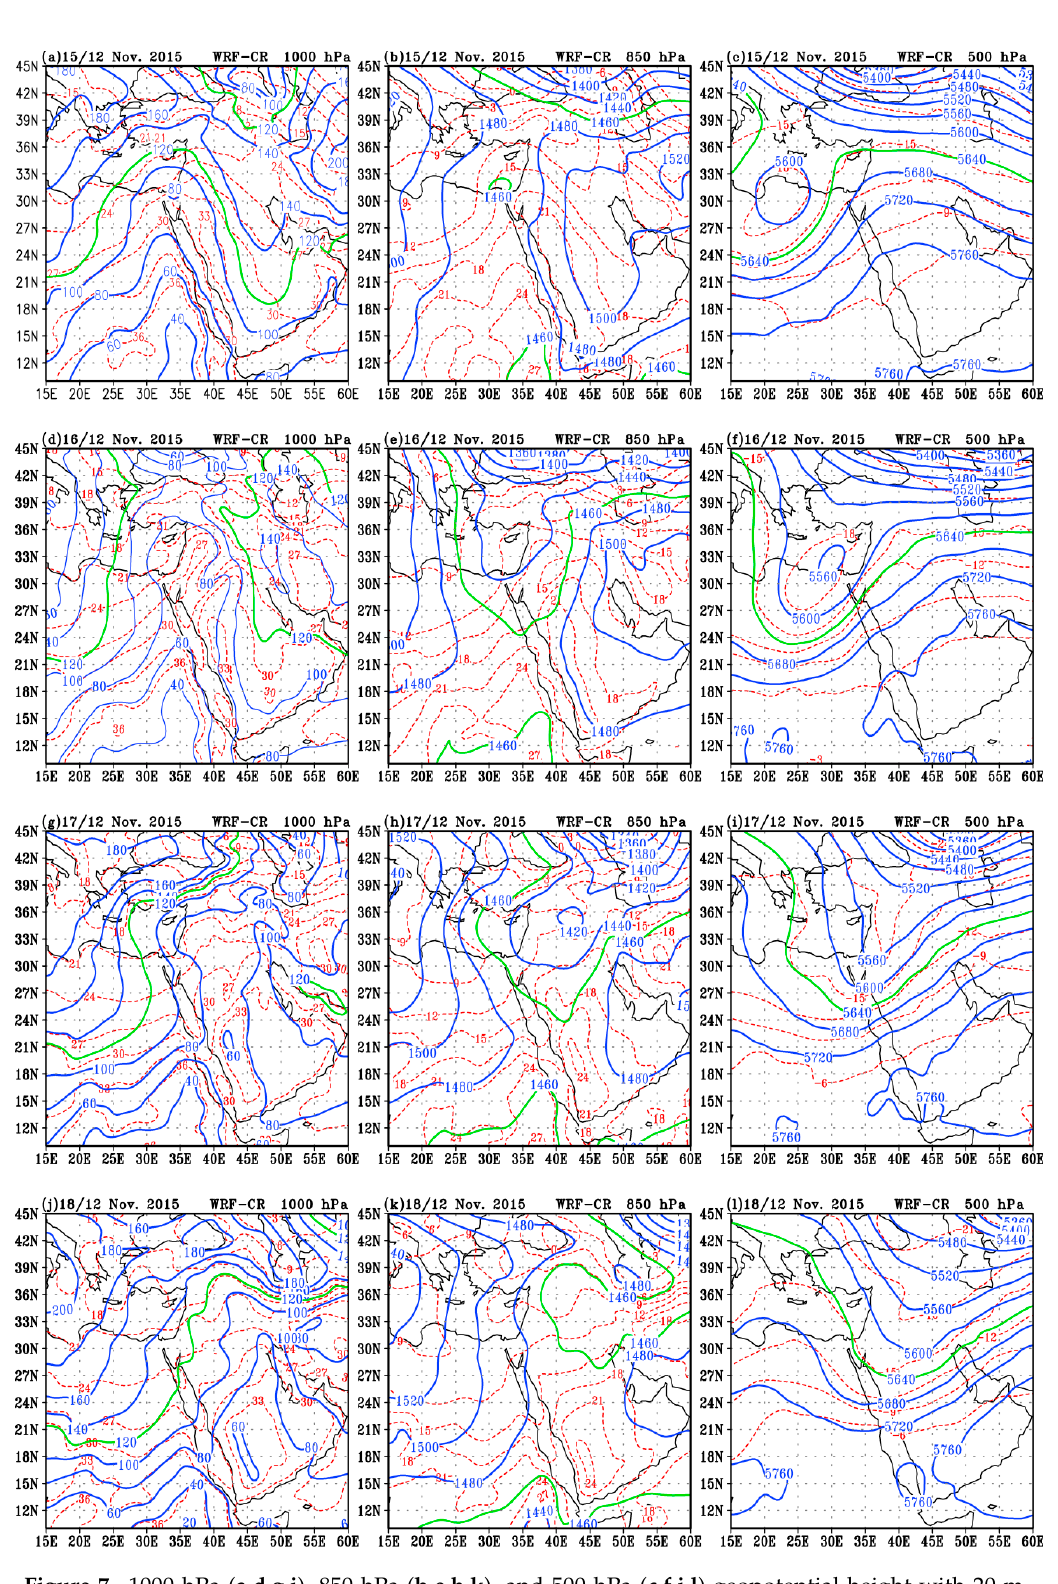
Figure 7. 1000 hPa ( a , d , g , j ), 850 hPa ( b , e , h , k ), and 500 hPa ( c , f , i , l ) geopotential height with 20 m contour intervals for 1000 and 850 hPa, and 40 m contour intervals for 500 hPa (blue and green solid lines), along with the temperature (red dashed lines) every 3 °C; was produced by the WRF control run at 12:00 UTC for the period 15–18 November 2015.